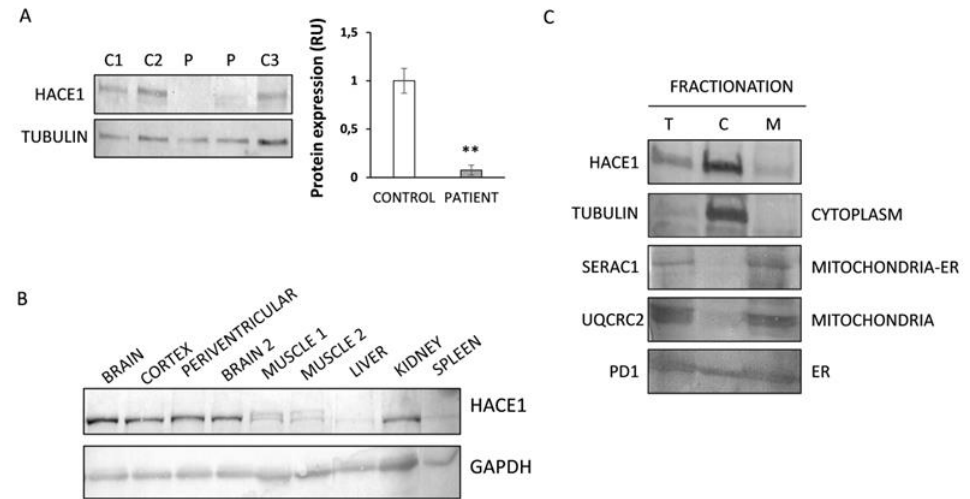
Figure 1. HACE1 protein expression analysis in patient fibroblasts and human tissues. ( A ) Western Blot analysis showed almost absent expression of HACE1 in patient fibroblasts. Extracts from several controls (C1: control 1; C2: control 2 and C3: control 3) and two di ff erent extracts from the patient were analysed. Tubulin was used as the loading control. ** p < 0.01. ( B ) Protein expression analysis in human control tissues showed a predominant HACE1 expression in brain samples. Glyceraldehyde-3-phosphate dehydrogenase (GAPDH) was used as the loading control. ( C ) Fractionation studies performed in control fibroblasts showed that HACE1 is mainly localized in the cytoplasmic fraction. Protein markers of di ff erent organelles (mitochondria, endoplasmic reticulum (ER) and cytoplasm) were studied in order to corroborate proper fractionation. The ER marker (PDI) showed a cytosolic leakage, a phenomenon already observed for this marker [26–28]. T: total extract; C: cytoplasmic extract; M: membranous organelle-enriched fraction extract.